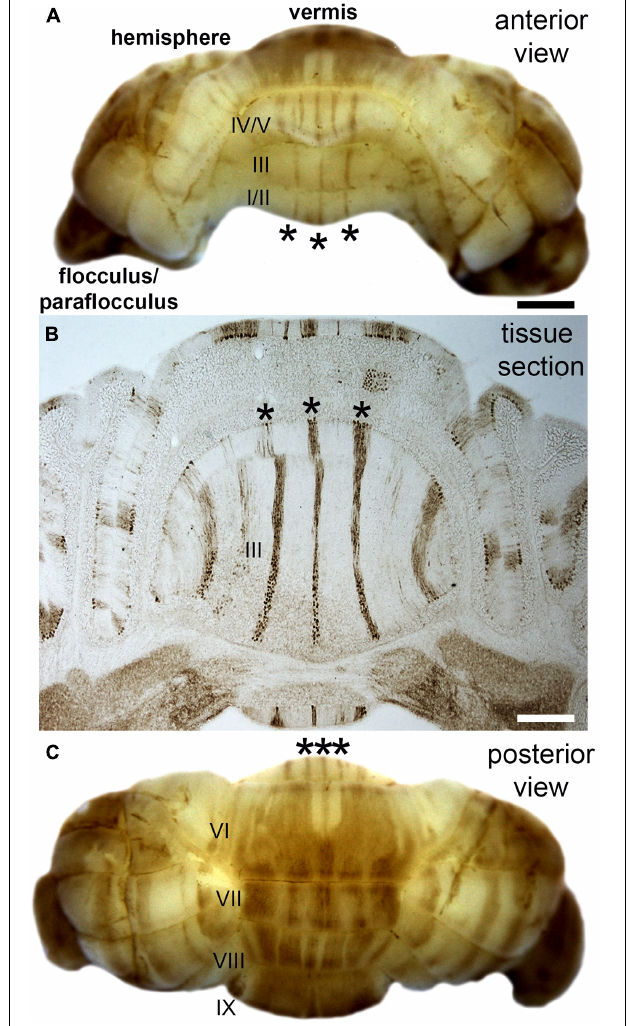
FIGURE 2 | Purkinje cell patterning in the adult mouse cerebellum. (A) Anterior view of the mouse cerebellum stained in wholemount with a monoclonal antibody to zebrin II/aldolaseC. (B) Coronal tissue section cut through the anterior cerebellum illustrating the pattern of zebrin II stripes in the anterior lobules (asterisks in all panels). Although the intervening stripes are not immunoreactive for zebrin II, they do express other markers that define this complementary set of stripes. (C) Posterior view of the mouse cerebellum stained in wholemount with zebrin II. The lobules in the vermis are labeled with Roman numerals according to the nomenclature of Larsell (Larsell, 1970). Scale bar in A = 1 mm (applies to C ), and the scale bar in B = 500 µ m. The images were modified with permission from White et al.